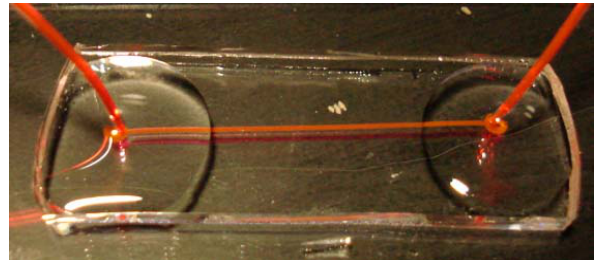
Fig. 3 PDMS microchip for calibration between thickness and fluorescence intensity